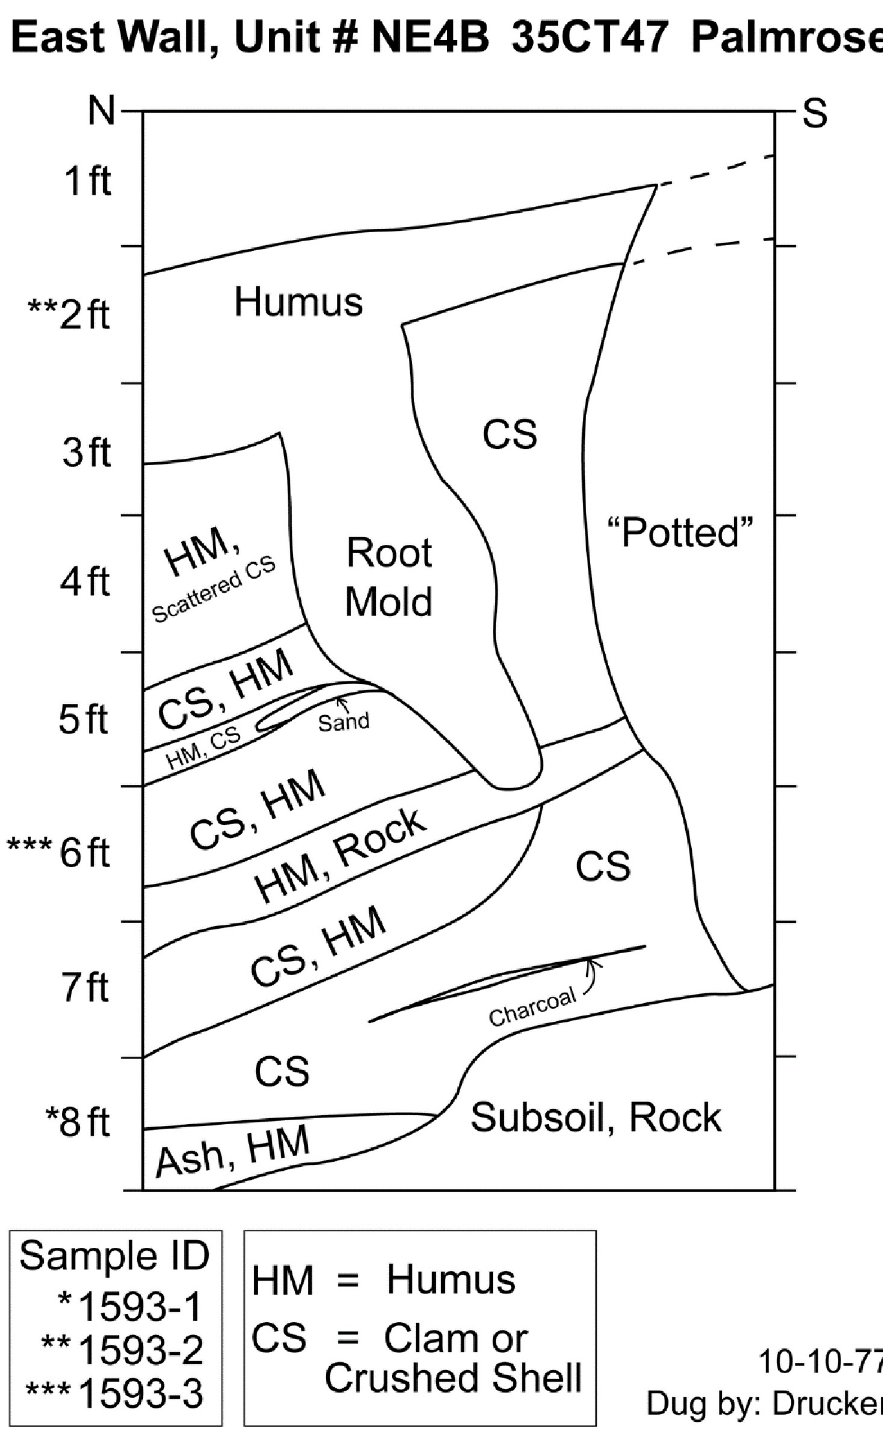
Fig 4. Palmrose unit NE4B east wall profile. Level provenience of radiocarbon samples